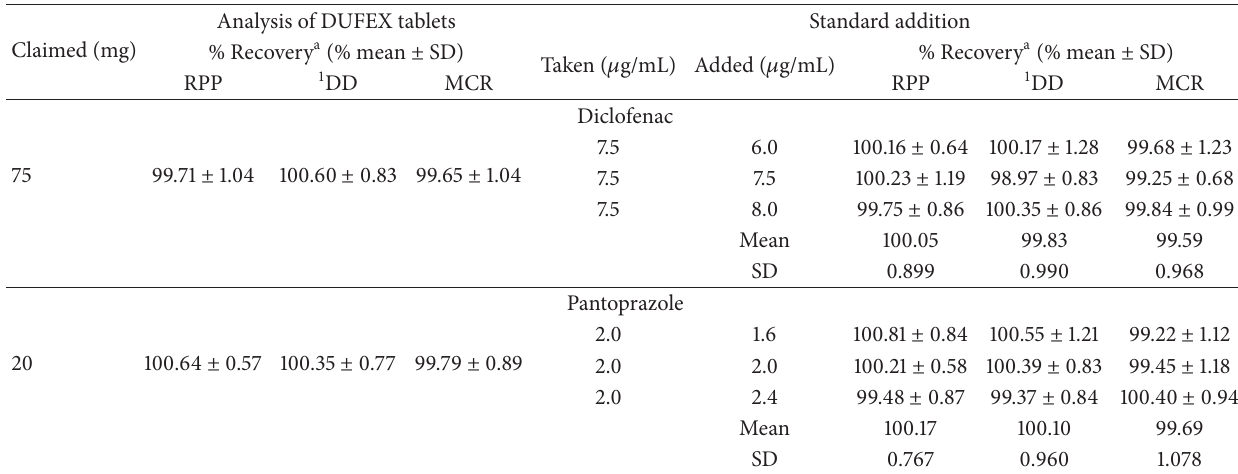
Table 4: Determination of diclofenac and pantoprazole in DUFEX tablets by the proposed methods and the application of standard addition technique.